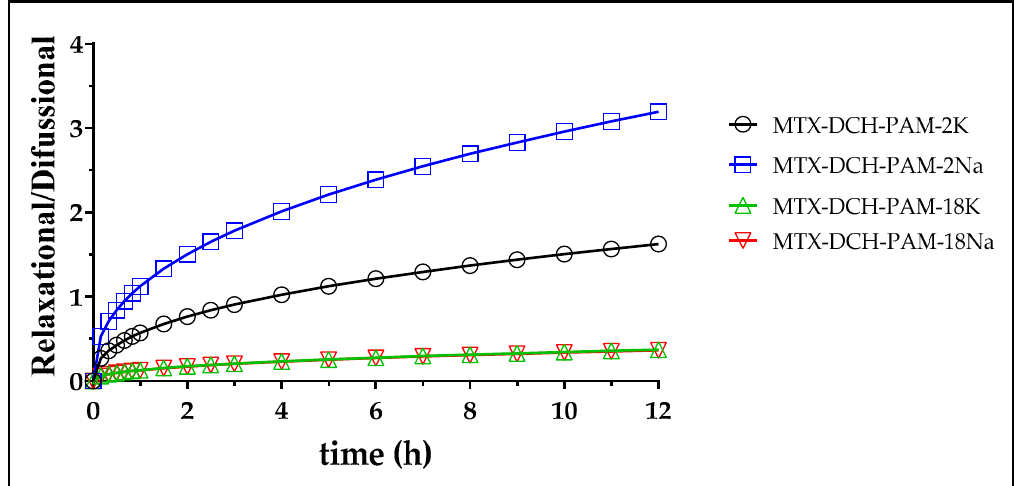
Figure 6. Relaxational to di ff usional ratio as a function of time for methotrexate release from nanoparticles at a pH of 7.4.